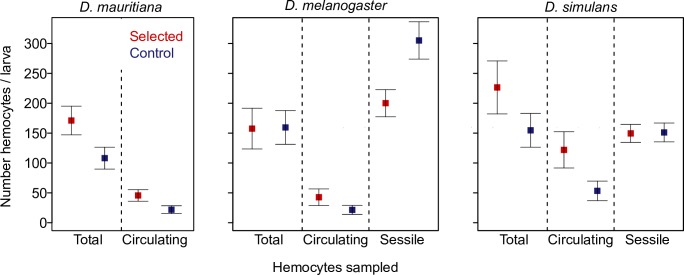
Mean number of hemocytes in populations of three Drosophila species that had been selected for parasitoid resistance and controls.The number of circulating hemocytes, the total number of hemocytes, and the number of sessile haemocytes under the dorsal cuticle. Hemocytes were counted in single 2nd instar larvae. Estimates of total hemocyte numbers were achieved by agitating larvae to disrupt sessile clusters of hemocytes into circulation prior to bleeding. The sessile hemocytes were counted in vivo by injecting E.coli BioParticles. These are fluoresce when phagocytosed by hemocytes, allowing the cells to be seen under the cuticle of live larvae. This was done in a separate experiment and at a different generation post-selection than the other data. Points are the mean number of hemocytes and bars are equal to 1 SE. The mean number of larvae contributing to each point on the plot is 145.